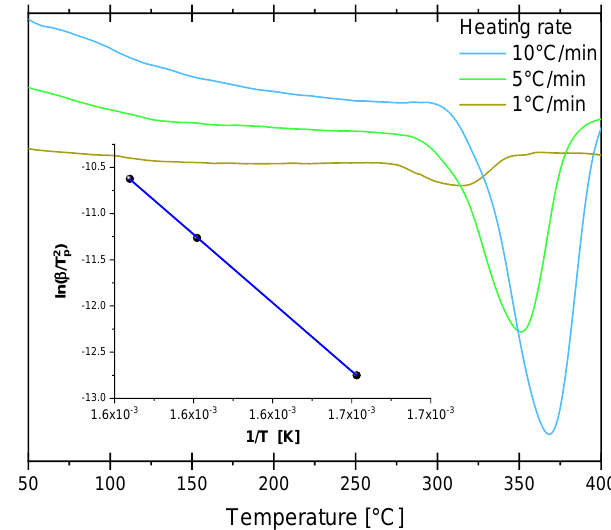
Figure 6. DSC trace of the dehydriding reaction of cryogenically prepared Mg-15wt.% VCl 3 hydrided at 350 °C/26 bar. Inset: Application of the Kissinger method for estimation of the dehydriding activation energy.